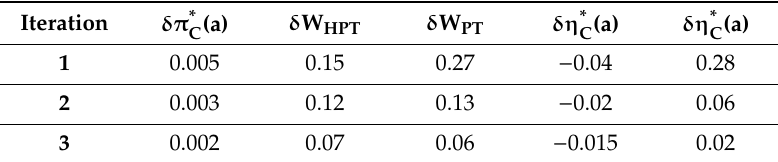
Table 6. Corrections for three first iterations.